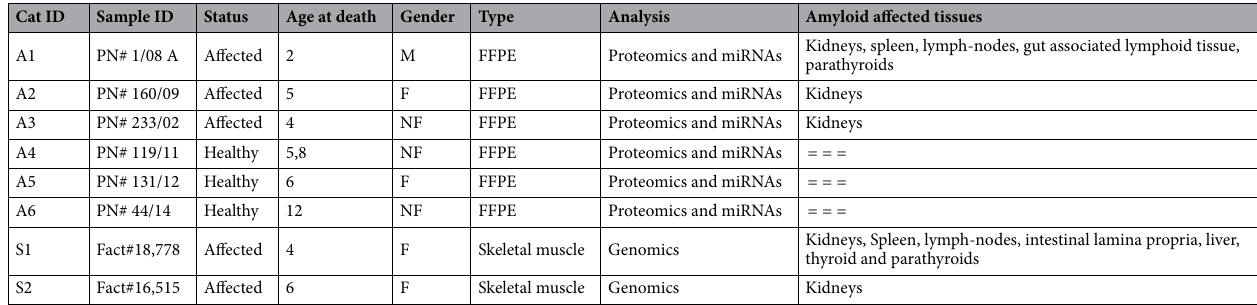
Table 1. Abyssinian samples used in the study. “Sample_ID”: Fcat# is the accession number at the whole genome sequence feline 99 Lives initiative, PN# is the protocol number at the Department of Veterinary Medicine, University of Milan. “Cat_ID” is the identification number used in the main text, Fig. 4 and Fig. 5. “Status” is the health status related to amyloidosis. “Age at death” is reported as years, months. “Gender”: M = Male, F = Female, NF = Neutered Female. “Type” is the specimen DNA has been extracted from. “Analysis” are the omic analyses the sample has been subjected to. “Amyloid affected tissues” are the tissues with amyloid deposits at